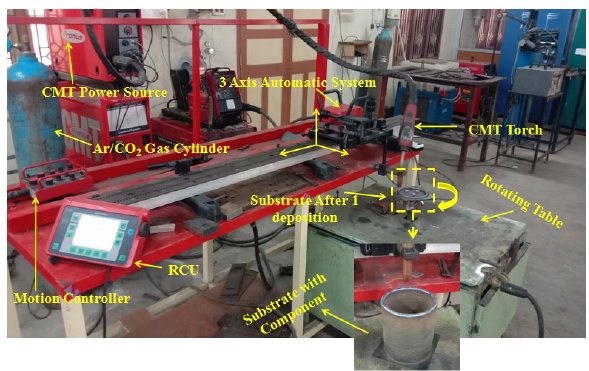
Figure 1: GMAW-WAAM platform used for